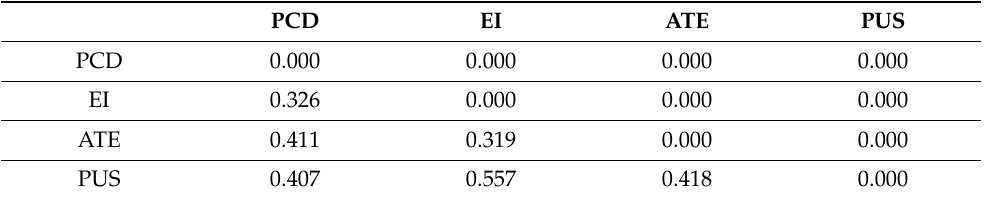
Table 2. Discriminant validity by heterotrait–monotrait ratio